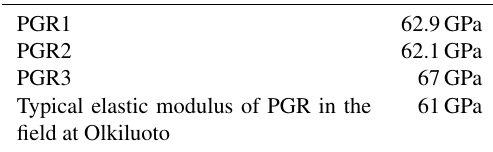
Table 2. Comparison of elastic modulus of the true-triaxial Peg- matitic samples and average elastic modulus measured in the